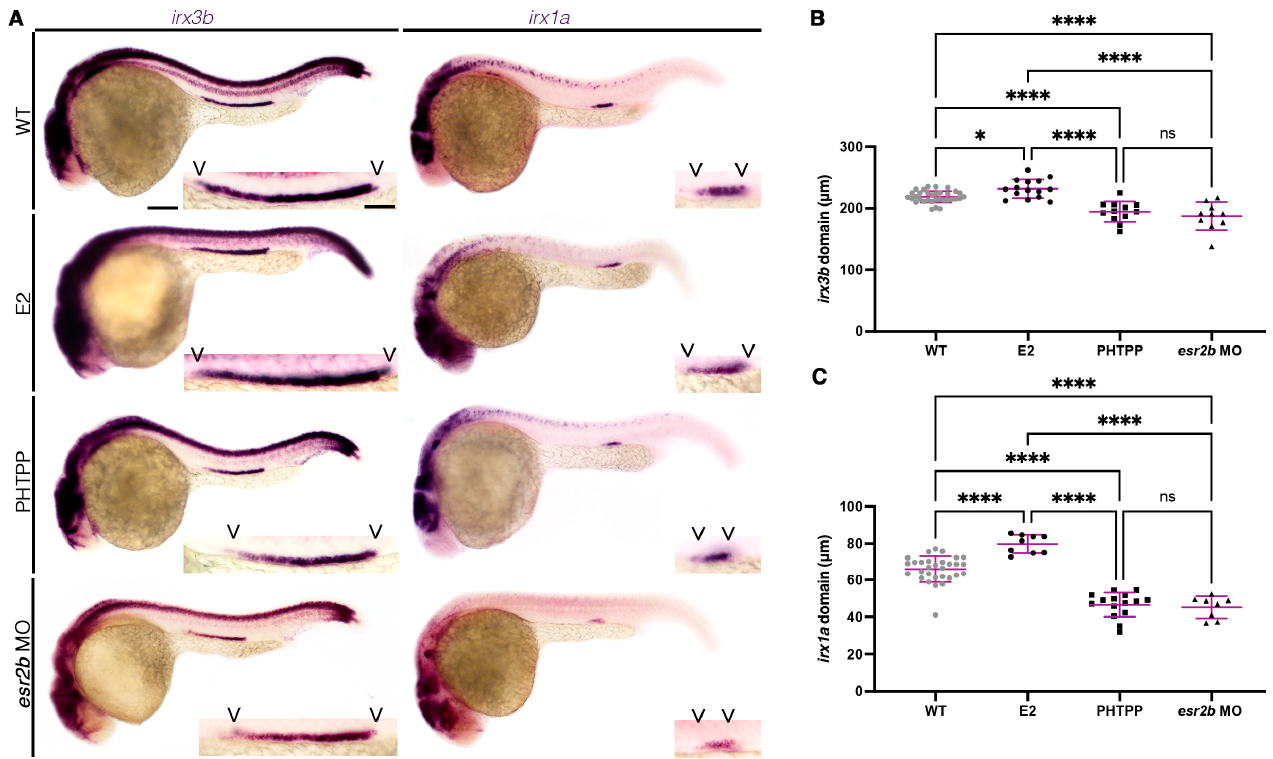
Figure 4. E2 signaling operates through Esr2b upstream of essential transcription factors to elicit distal nephron cell fate. ( A ) The 28 ss WT (top), 20 µM E2-treated (second row), 18 µM PHTPP-treated (third row), or esr2b MO-injected (bottom) animals stained via WISH for the transcription factor irx3b (left) and its downstream target irx1a (right). Scale bar = 100 µ m for lower magnification, scale bar = 50 µ m for higher magnification. ( B , C ) The irx3b and irx1a domain lengths at 28 ss in micrometers. Data presented on graphs are represented as mean ± SD. * p < 0.05 and **** p < 0.0001